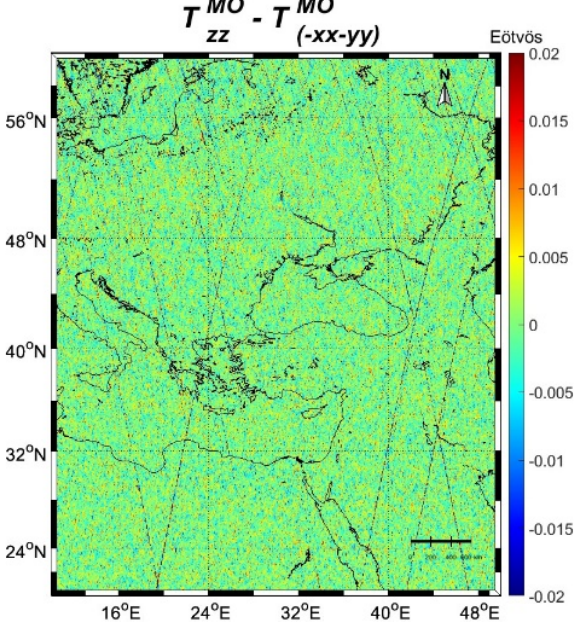
Figure 7. ( a ) The filtered synthesized 𝑇 (cid:2936)(cid:2936)(cid:3014)(cid:3016) 𝑓𝑖𝑙𝑡 at MO = 230 km, ( b ) the DC free-air gravity anoma- lies on earth’s surface (𝛥𝑔𝑓 𝑓𝑖𝑙𝑡) , ( c ) their residuals (𝛥𝑔𝑓 (cid:3045)(cid:3032)(cid:3046) 𝑓𝑖𝑙𝑡) with the ground data based on TIM_R6 d/o 300.